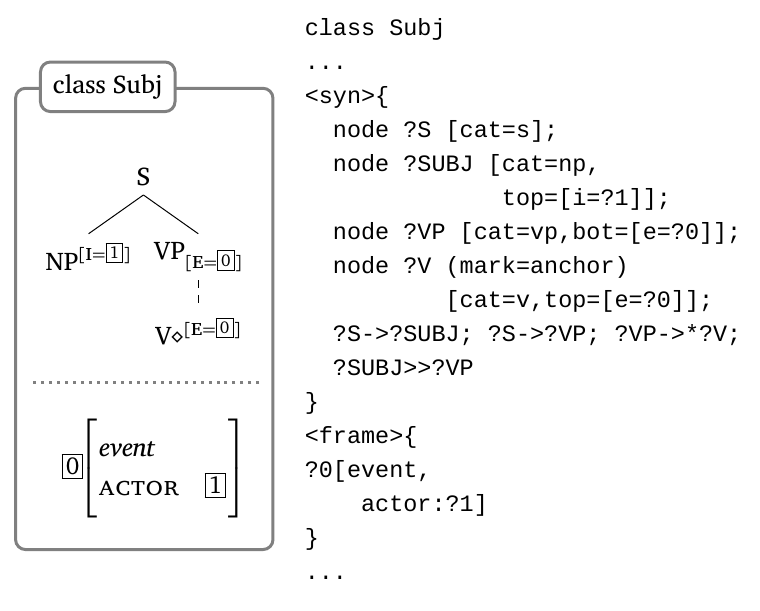
Figure 12: Implementation of class